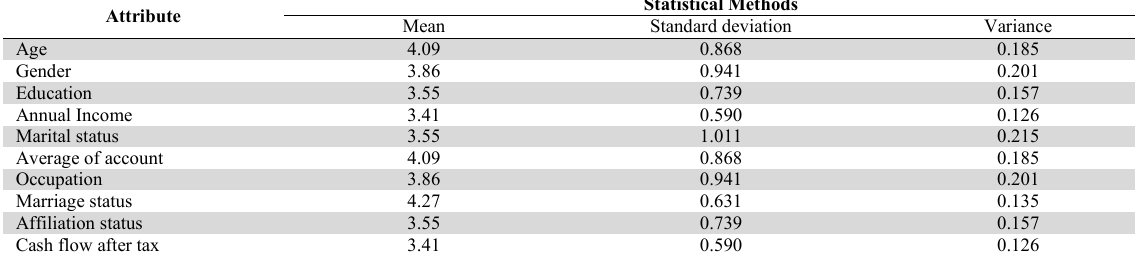
Statistical analysis of data set (bank 2)